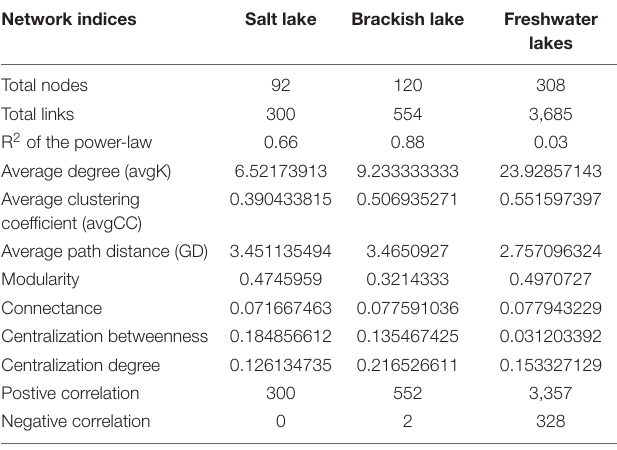
TABLE 2 | Topological properties of the microbial network.